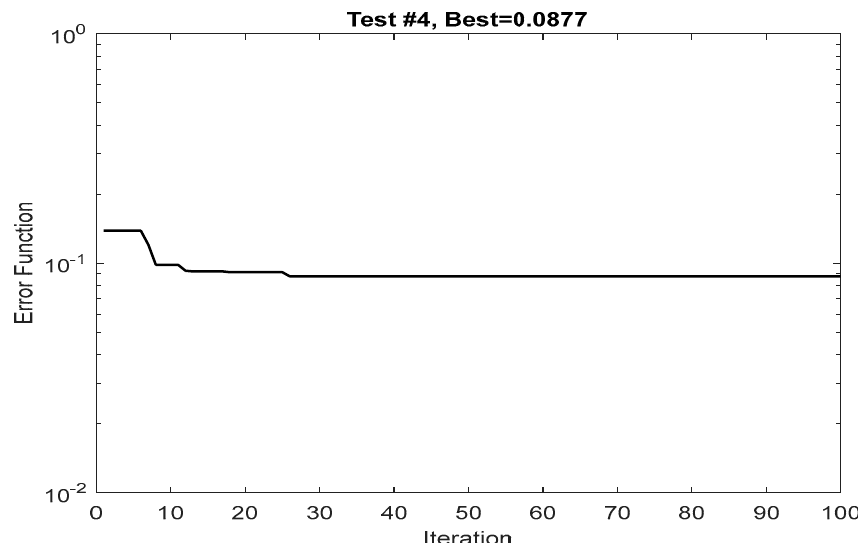
Figure 15. Variation in the error function at each iteration of the Genetic Algorithm in test #4.